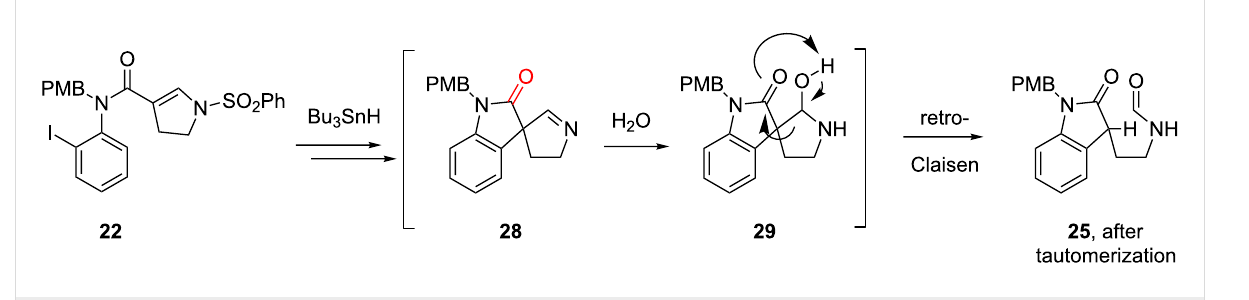
Figure 5: ORTEP representation of the crystal structure of 27 .